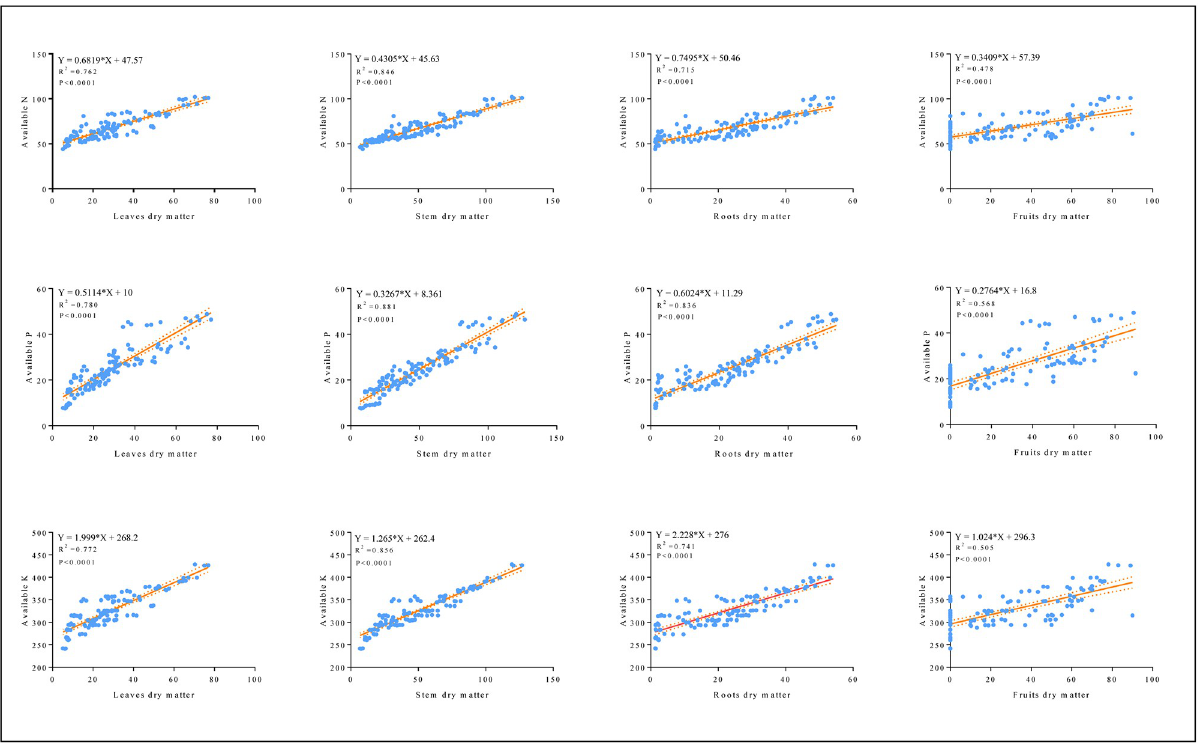
Fig 3. The relationship between soil available nutrients and dry matter in different mixing ratio irrigation